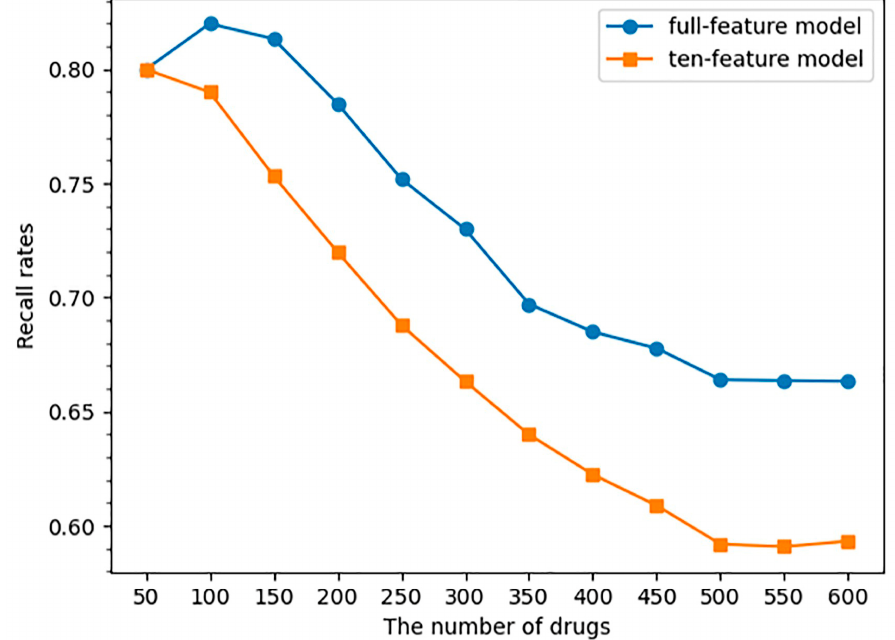
Figure 4. The trend of recall rate changed when the number of drugs increased in the dataset. The Y-axis indicates the recall rate, and the X-axis is the number of drugs used for the prediction. Table 4. The top ten QT-prolonging drugs with the highest ROR values.